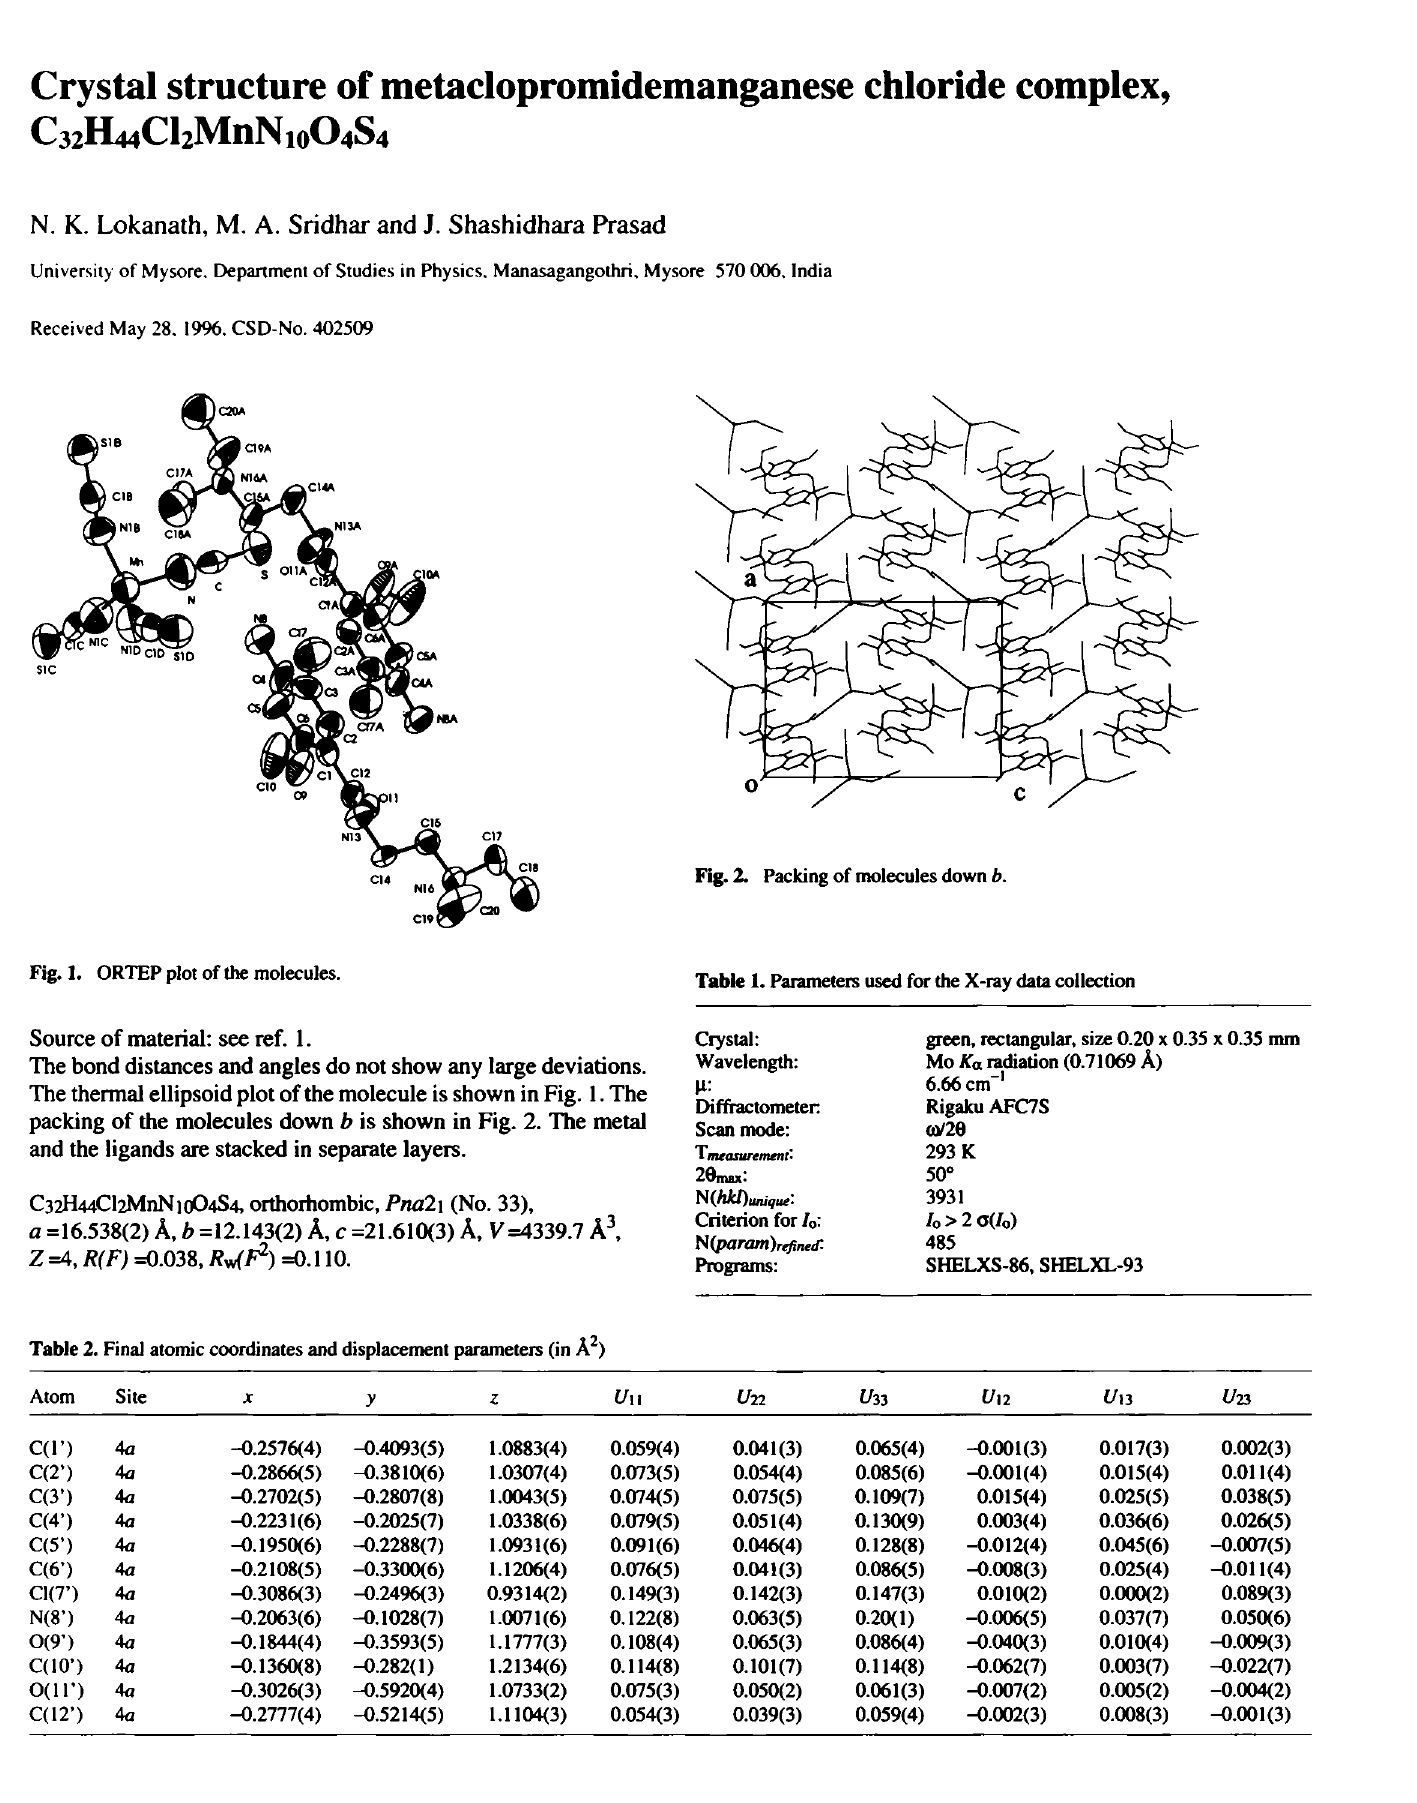
Table 2. Final atomic coordinates and displacement parameters (in A 2